Question: What type of chart is this?
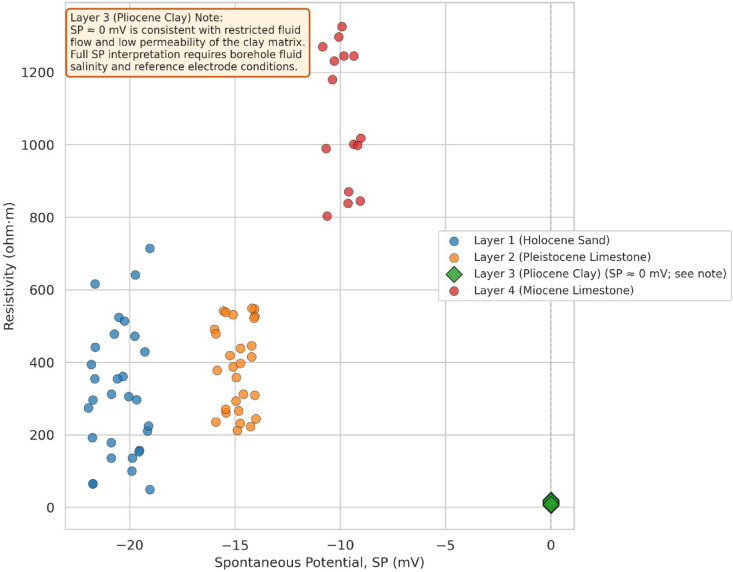
Answer: scatter